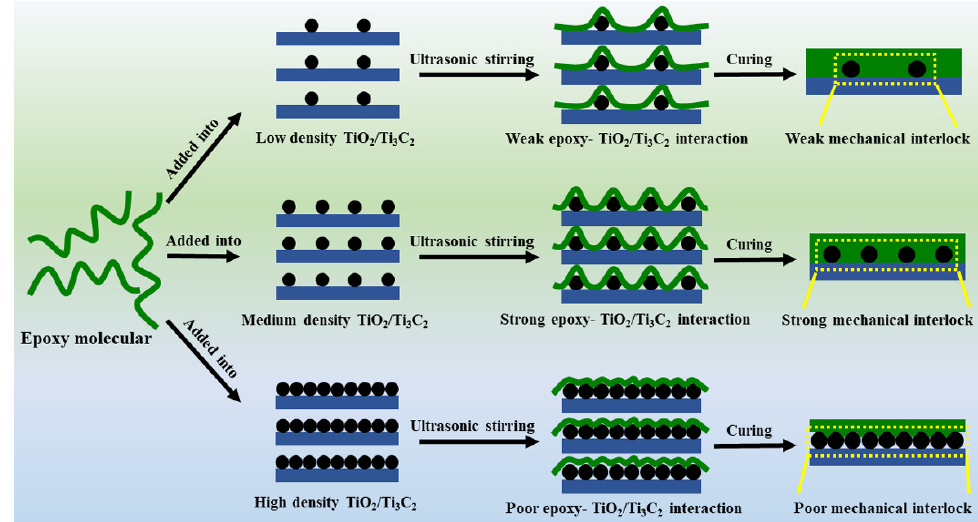
Scheme 2. Illustration for the interaction between TiO 2 /Ti 3 C 2 and epoxy matrix in TiO 2 /Ti 3 C 2 /epoxy